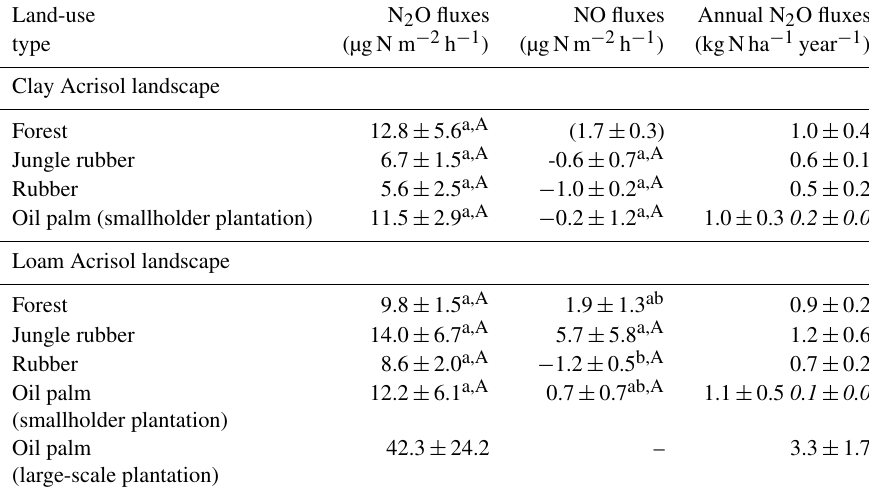
Table 1. Mean ( ± SE, n = 4 sites) soil N 2 O (with 12 monthly measurements) and NO fluxes (with four monthly to bimonthly measurements) as well as annual soil N 2 O fluxes from different land uses within each landscape in Jambi, Indonesia. Means followed by different lowercase letters indicate significant differences among land uses within each landscape and different capital letters indicate significant differences between landscapes within each land use (linear mixed-effect models with Fisher’s LSD test at P ≤ 0 . 09). For soil NO fluxes in the clay Acrisol, forest was excluded in the comparison among land uses because measurements were only carried out in two sites. Annual soil N 2 O fluxes are calculated from the monthly fluxes using the trapezoidal rule. For smallholder oil palm plantations, values in italics were the fertilizer-induced annual soil N 2 O fluxes (see Sect. 2.2). In the loam Acrisol landscape, soil N 2 O fluxes were additionally measured in a large-scale oil palm plantation (mean ± SE, n = 4 replicates); these fluxes did not differ from those of smallholder plantations within the same landscape (linear mixed-effect models with Fisher’s LSD test; P = 0 .